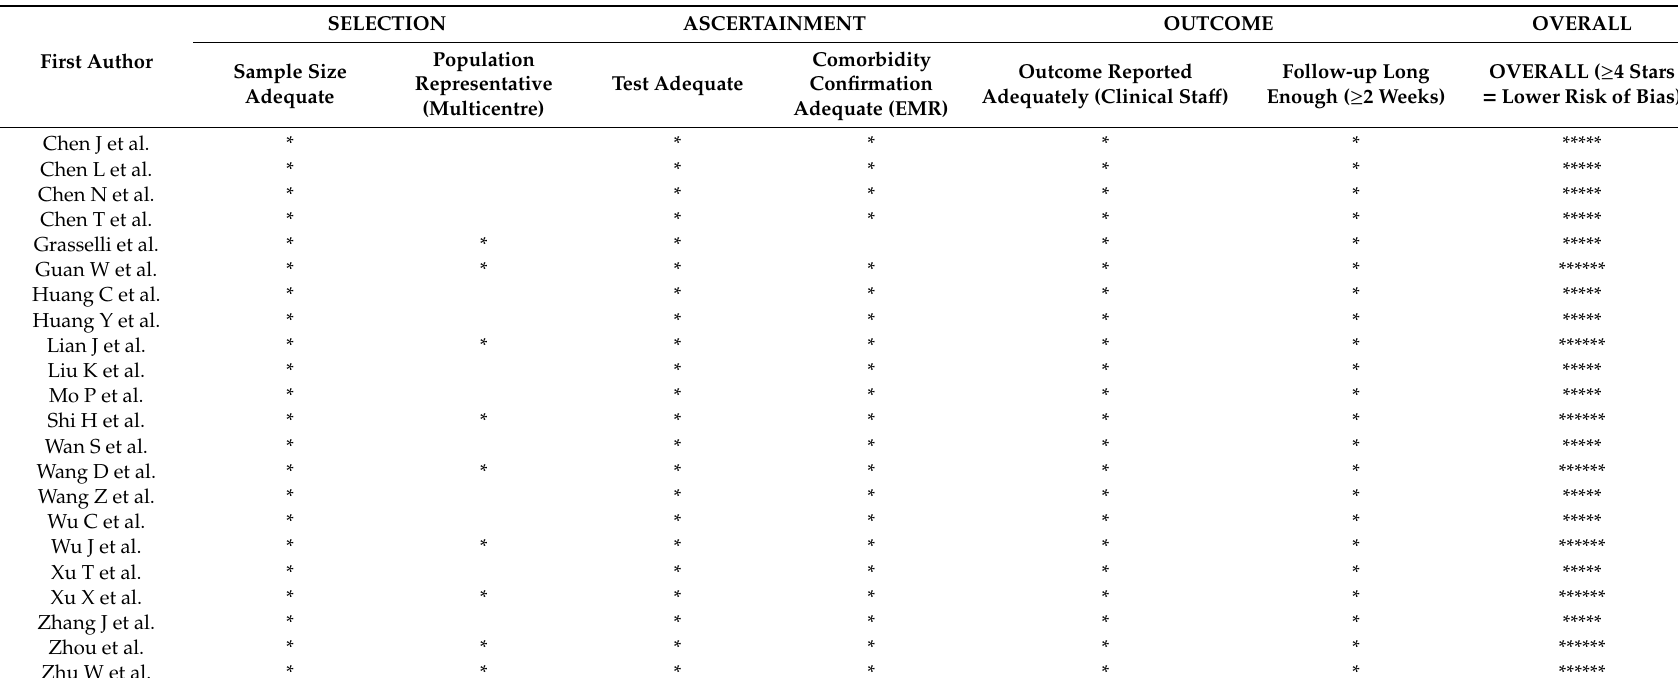
Table A1. Quality